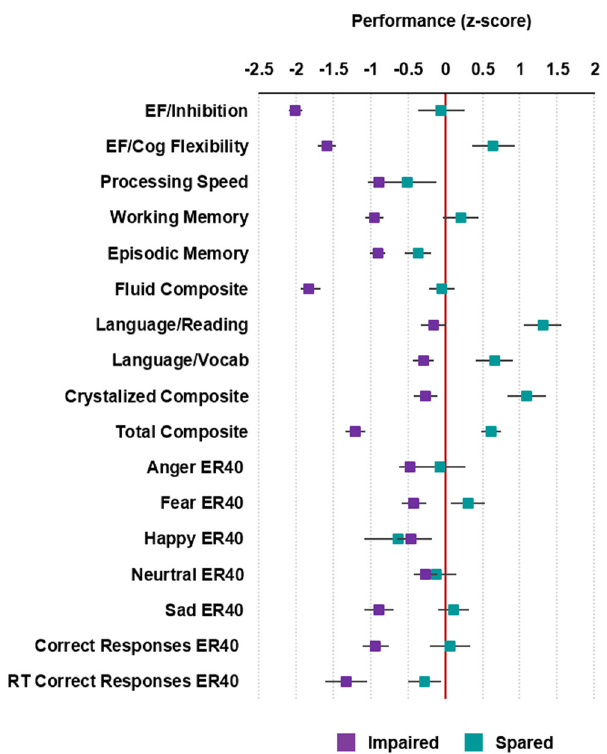
FIGURE 1 | Cognitive profiles of the patients with schizophrenia. Average standardized cognitive performance profiles in the impaired and spared cognitive subgroups identified using HYDRA clustering. Error bars represent standard error. For RT Correct Responses ER40, the directionality of values was reversed so that higher values denote better performance. Executive Function/Inhibition: NIH Toolbox Flanker Inhibitory Control and Attention Test; Executive Function (EF)/Cognitive Flexibility: NIH Toolbox Dimensional Change Card Sort Test; Processing Speed: NIH Toolbox Pattern Comparison Processing Speed Test; Working Memory: NIH Toolbox List Sorting Working Memory Test; Episodic Memory: NIH Toolbox Picture Sequence Memory Test; Fluid IQ: NIH Toolbox Cognition Fluid Composite; Language/Reading: NIH Toolbox Oral Reading Recognition Test; Language/Vocabulary: NIH Toolbox Picture Vocabulary Test; Crystalized IQ: NIH Toolbox Cognition Crystallized Composite; Full IQ: NIH Toolbox Cognition Total Composite Score; Penn Emotion Recognition Test: Number of Correct Anger Identifications: Anger ER40; Penn Emotion Recognition Test: Number of Correct Fear Identifications: Fear ER40; Penn Emotion Recognition Test: Number of Correct Happy Identifications: Happy ER40; Penn Emotion Recognition Test: Number of Correct Neutral Identifications: Neutral ER40; Penn Emotion Recognition Test: Number of Correct Sad Identifications: Sad ER40; Penn Emotion